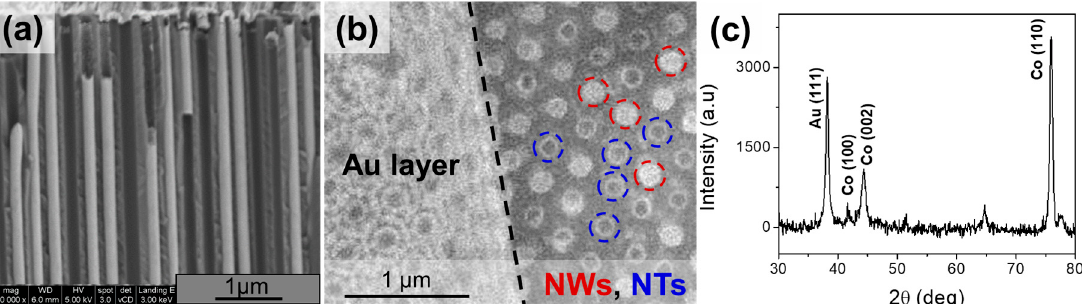
Figure 2. ( a ) Cross-section SEM image of AAO membrane filled with Co nanotubes; ( b ) top-view SEM image of nanotubes sample before and after a part of the Au layer was removed to image the nanostructures embedded into membrane; and ( c ) XRD pattern of the nanotubes within the AAO template whose peaks correspond to hcp Co phase and to the back sputtered Au layer.